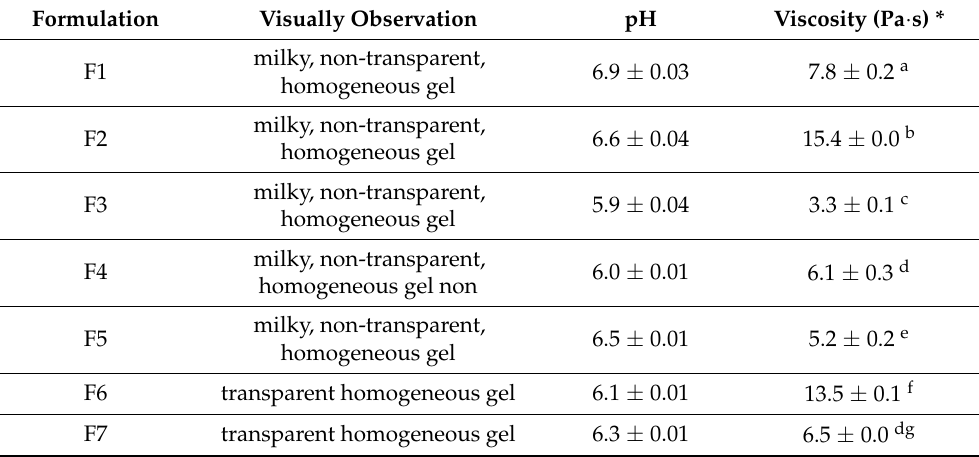
Table 1. Visual observation, pH, and viscosity of the gel formulations (mean ± SD, n = 3).